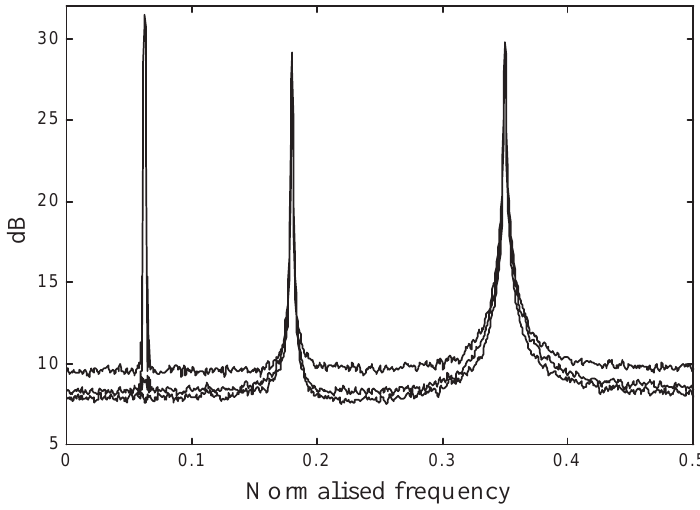
Fig. 4. A typical example where the FDD technique is taken at fault. Three output signals were simulated by exciting a linear system with three independent white forces. Resonances are as in Fig. 1. Independent additive noises were added on the outputs such as to produce a signal-to-noise ratio of 20